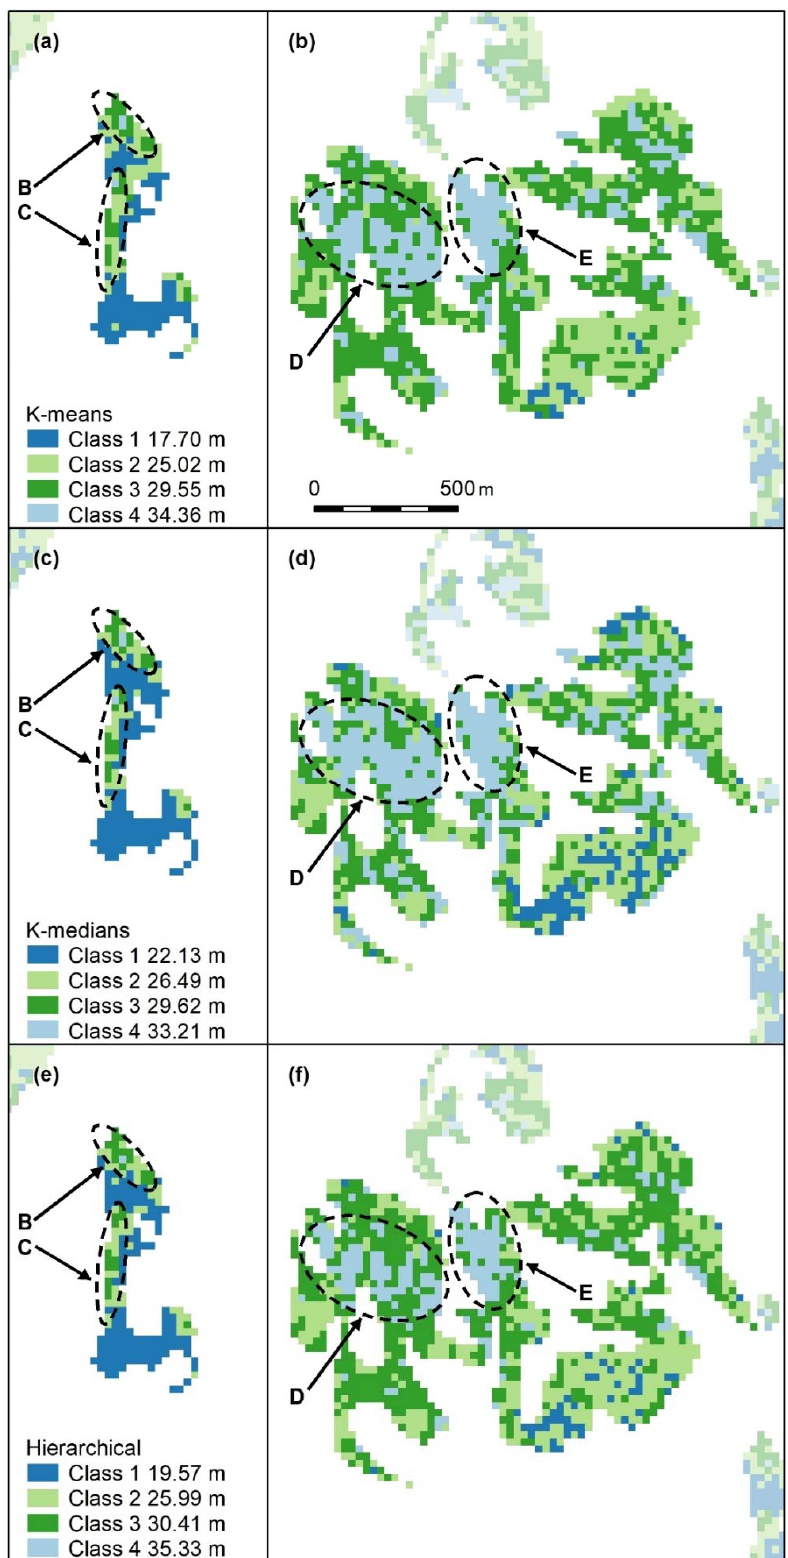
Figure A14. Nonspatial algorithm (K ‐ means, a , b ; K ‐ medians c , d ; hierarchical, e , f ) cluster maps with 4 classes. Letters B–E indicate areas of higher canopy. Features B and C are captured by all algorithms, but D and E are best captured by K ‐ medians ( c , d ). Panel scores: K ‐ means = 6, K ‐ medians = 10, and Hierarchical = 8.